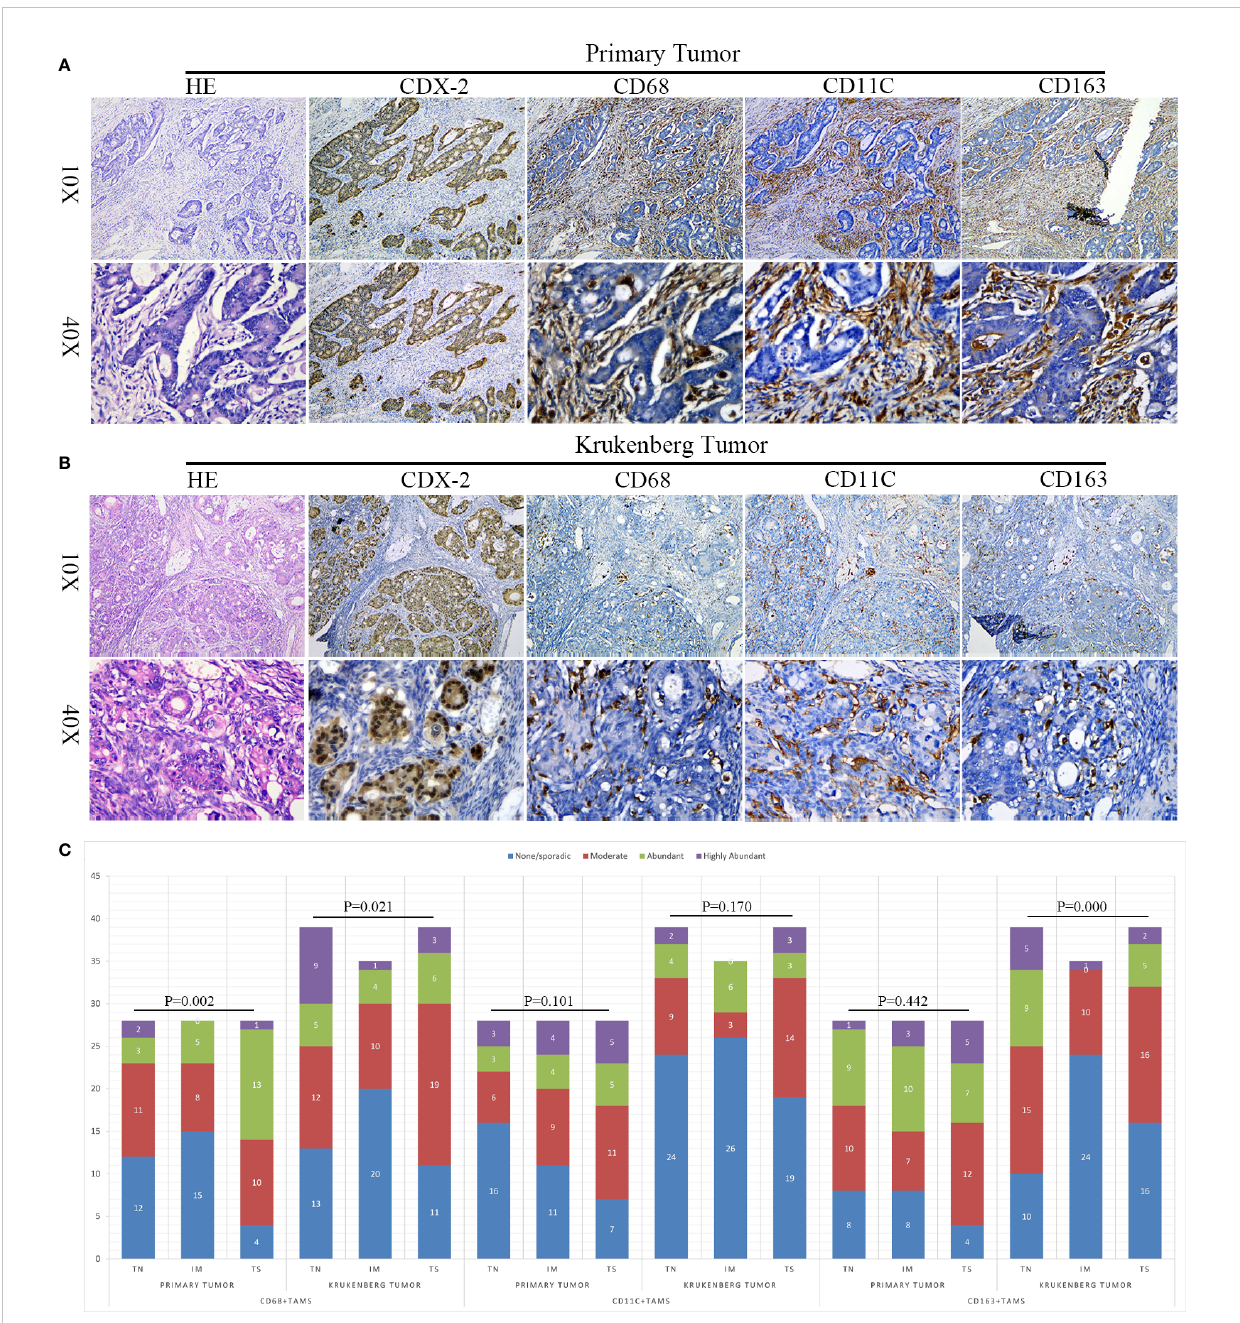
FIGURE 3 Expression and differential distribution of TAMs in primary tumors and KT tissues. (A, B) Representative images of HE, CDX-2, CD68, CD11c, and CD163 staining in primary tumor and KT tissues. (C) Spatial distribution characteristics of TAMs in primary tumors and KT tissues. The Y-axis denotes the number of